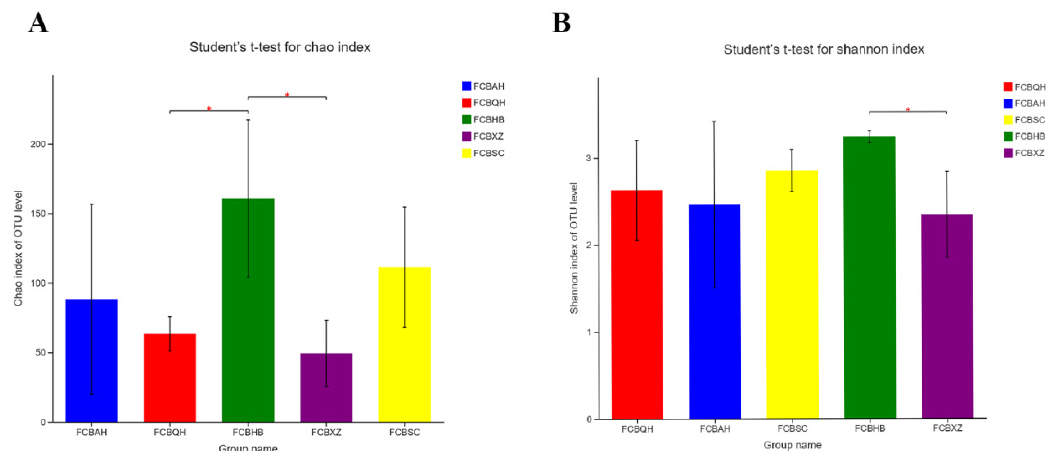
Figure 2. ( A ) Statistically significant different Chao indexes of the five FCB groups; ( B ) statistically significant different Shannon indices of the five FCB groups. The abscissa is the group name and the ordinate is the exponntial average index of each group. * represents p ≤ 0.05.